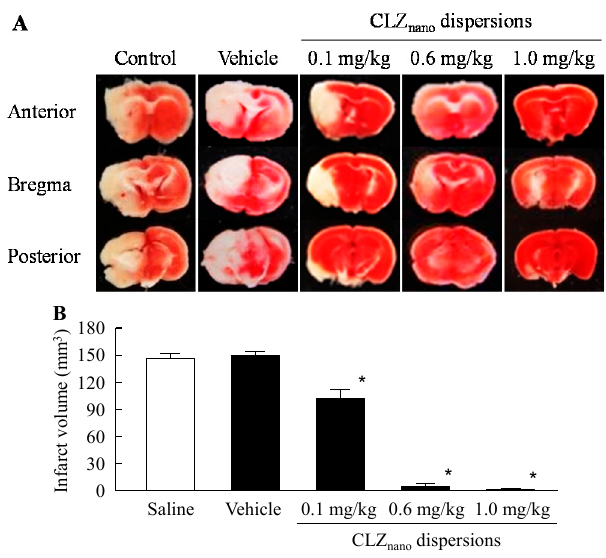
Figure 6. Protective effect of dispersions containing CLZ nanoparticles on ischemic stroke in MCAO/reperfusion mice. ( A ) Image of the brain (the bregma and 1 mm anterior and 1 mm posterior to the bregma) of MCAO/reperfusion mice treated with CLZ nano dispersion; ( B ) Infarct volume of MCAO/reperfusion mice treated with CLZ nano dispersion. MCAO was induced by inserting a silicone-coated 8-0 nylon monofilament into the left middle cerebral artery. Two hours after this procedure, the middle cerebral artery blood flow was restored by withdrawing the nylon monofilament. At 3 h after reperfusion, saline, vehicle, 0.1 mg/kg CLZ nano , 0.6 mg/kg CLZ nano or 1.0 mg/kg CLZ nano dispersion was injected into the tail vein; three days after injection, the brains were removed. The data are presented as means ± S.E. of seven independent mice. * p < 0.05, vs. Saline.